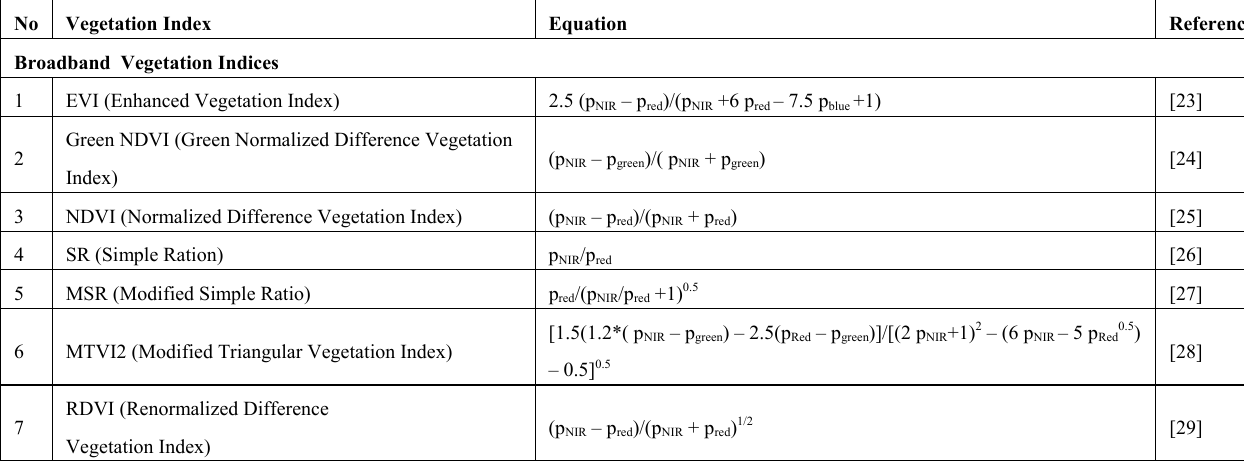
Table 1. Vegetation indices used for the aims of the study (both broadband and